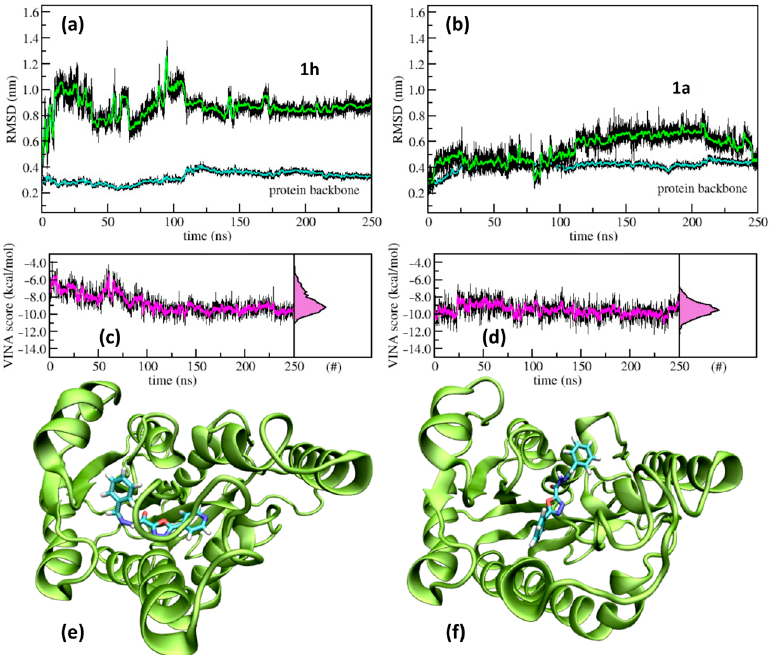
Figure 3. Molecular dynamics simulation results. ( a , b ) Root mean squared deviation (RMSD) of 1a ( a ) and 1h ( b ) with respect to their initial bound configuration (green), and RMSD of the receptor backbone (cyan); ( c , d ) Autodock Vina scores calculated over 2500 configurations extracted from the 250 ns long molecular dynamics trajectories for 1a ( c ) and 1h ( d ), on the right side of each panel the score distributions are shown; color code: running averages calculated over 1 ns (green, cyan, magenta), datapoints (black); ( e , f ) end simulations snapshots for 1a ( e ) and 1h ( f ), water molecules have been removed for ease of interpretation. Table 3. In silico predicted main pharmacokinetic characteristics of five compounds ( 1h, 1k–n ). To allow better comparison, information on the reference compound isoniazid ( INH ) is